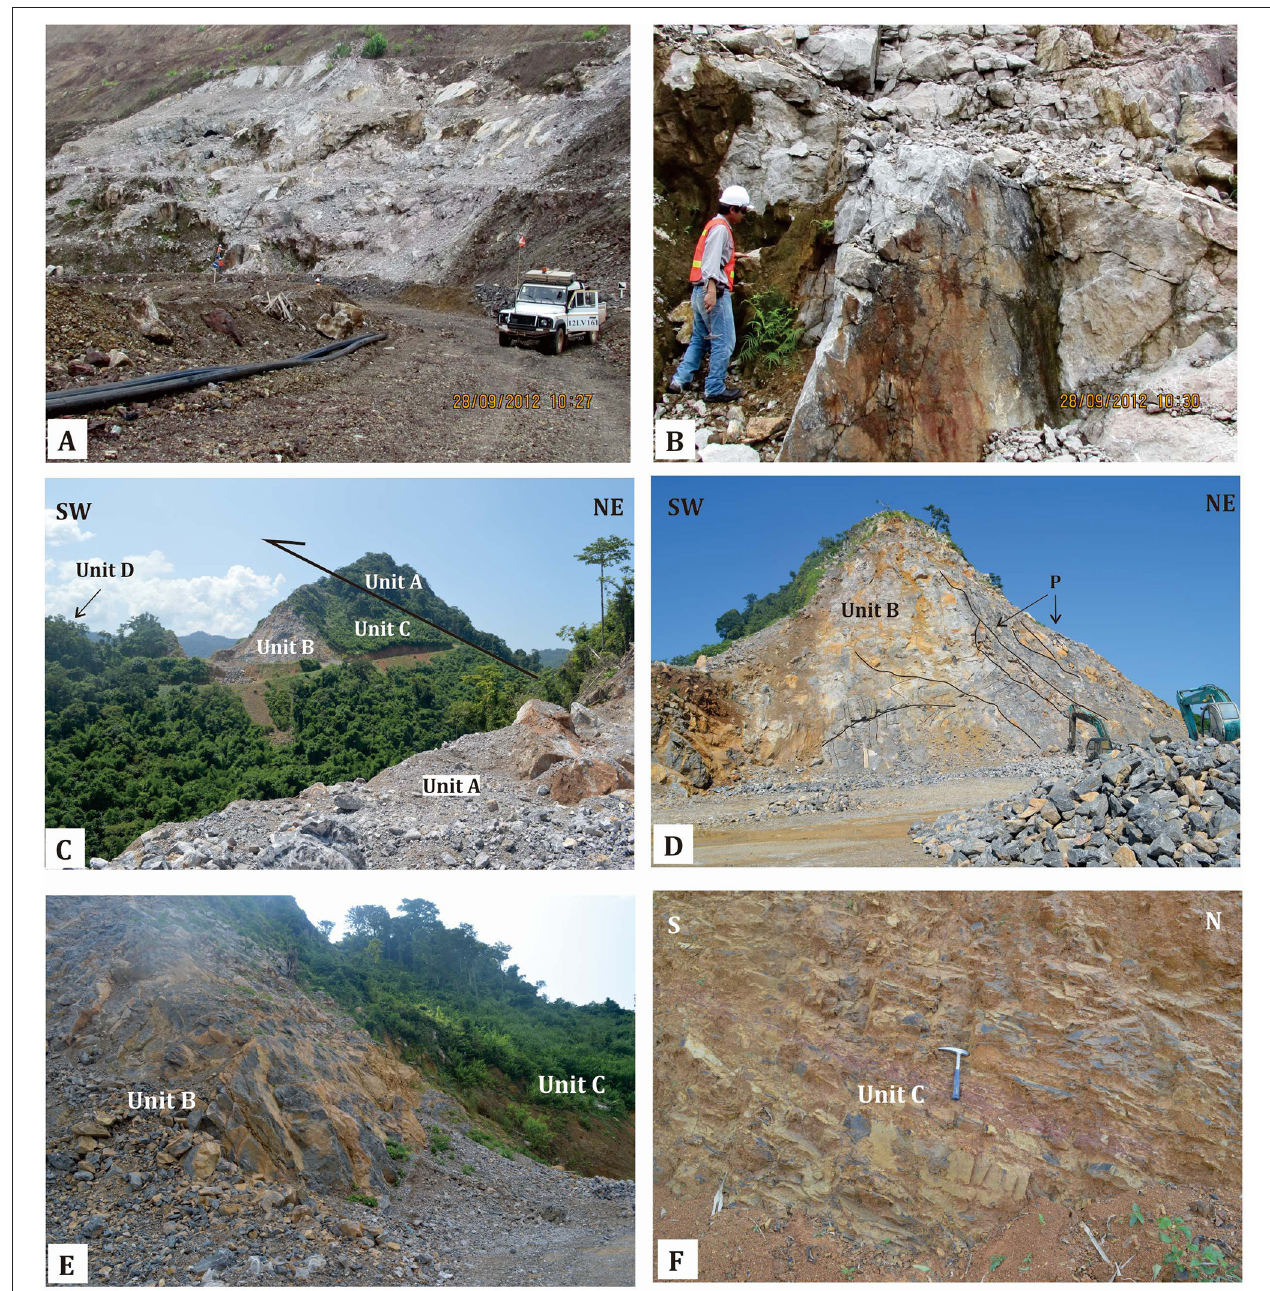
FIGURE 9 | Deformed and stratigraphically out-of-sequence light colored Wenlockian age limestone associated with black early Silurian graptolitic shales, and late Silurian radiolarian cherts of the Vang Ngang Formation at Sepon Mine, Laos. Southern margin of Truong Son Terrane. This is possibly an accretionary prism. (A) Sharp contact of Wenlockian limestone unit with Llandoverian shale and Ludlovian chert sequence. (B) Close-up of Wenlockian limestone showing strongly sheared block of the limestone [see Loydell et al. (2019) and Thassanapak et al. (2018) for details].Truong Son Terrane, Laos. Field photographs of limestone quarry 20km south of the Sepon mine but north of Tamky-Phuoc Son Suture ( Figure 1 for location), near southern margin of Truong Son Terrane showing Middle to Late Devonian and lower Carboniferous carbonate and younger siliciclastic succession. (C) Showing thrust slice of Middle to Upper Devonian carbonate succession (Unit A, as seen in foreground) over lower Carboniferous carbonate-siliciclastics (Units B, C, and D). (D) Main quarry showing complex structure including thrust fault with phacoid (P) and recumbent fold with vergence to the south. (E) Gradational contact between Unit B and Unit C showing evidence of upwards shallowing. (F) Unit C, siliciclastics - mainly light brown and red shale, interbedded with thin bedded siltstone and sandstone of a probable deltaic environment.